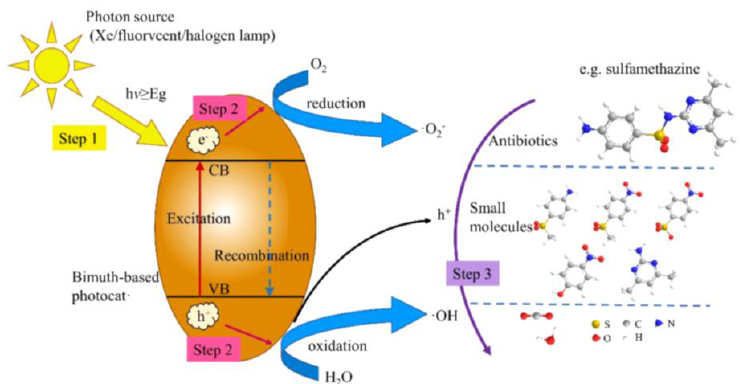
Figure 1. Degradation mechanisms of antibiotics by bismuth-based photocatalysts: absorption of photons with energy higher than the material bandgap, excitation, and reaction. Reproduced with permission from [45]. Copyright 2021 Elsevier.